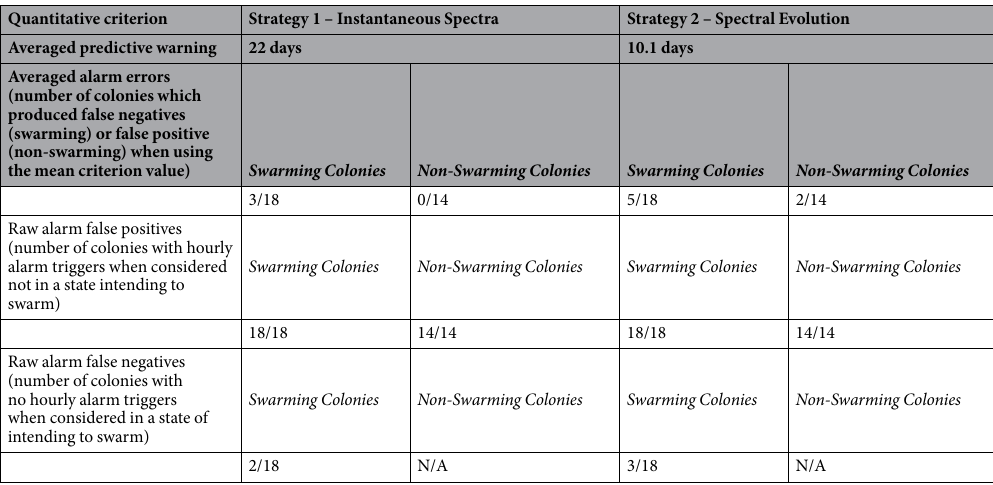
Table 1. Quantitative comparison of the performance evidence for each swarm prediction strategy discussed in this